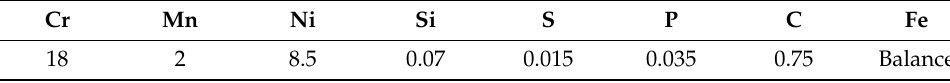
Table 1. Chemical composition of the 304 SS used in this work (wt.%).